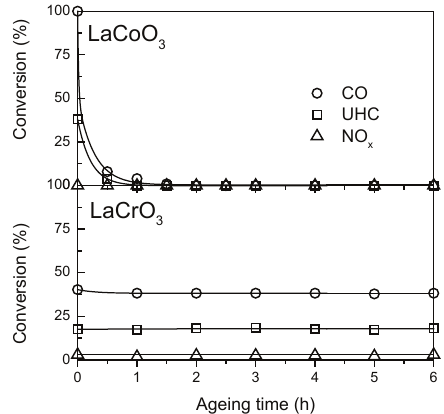
Figure 4. TWC activity of LaCoO